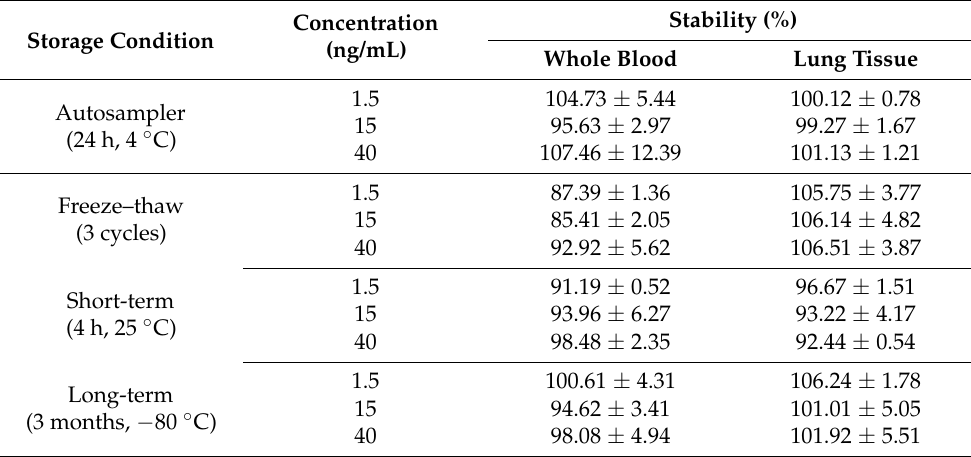
Table 5. Stability of sirolimus in porcine whole blood and lung tissue